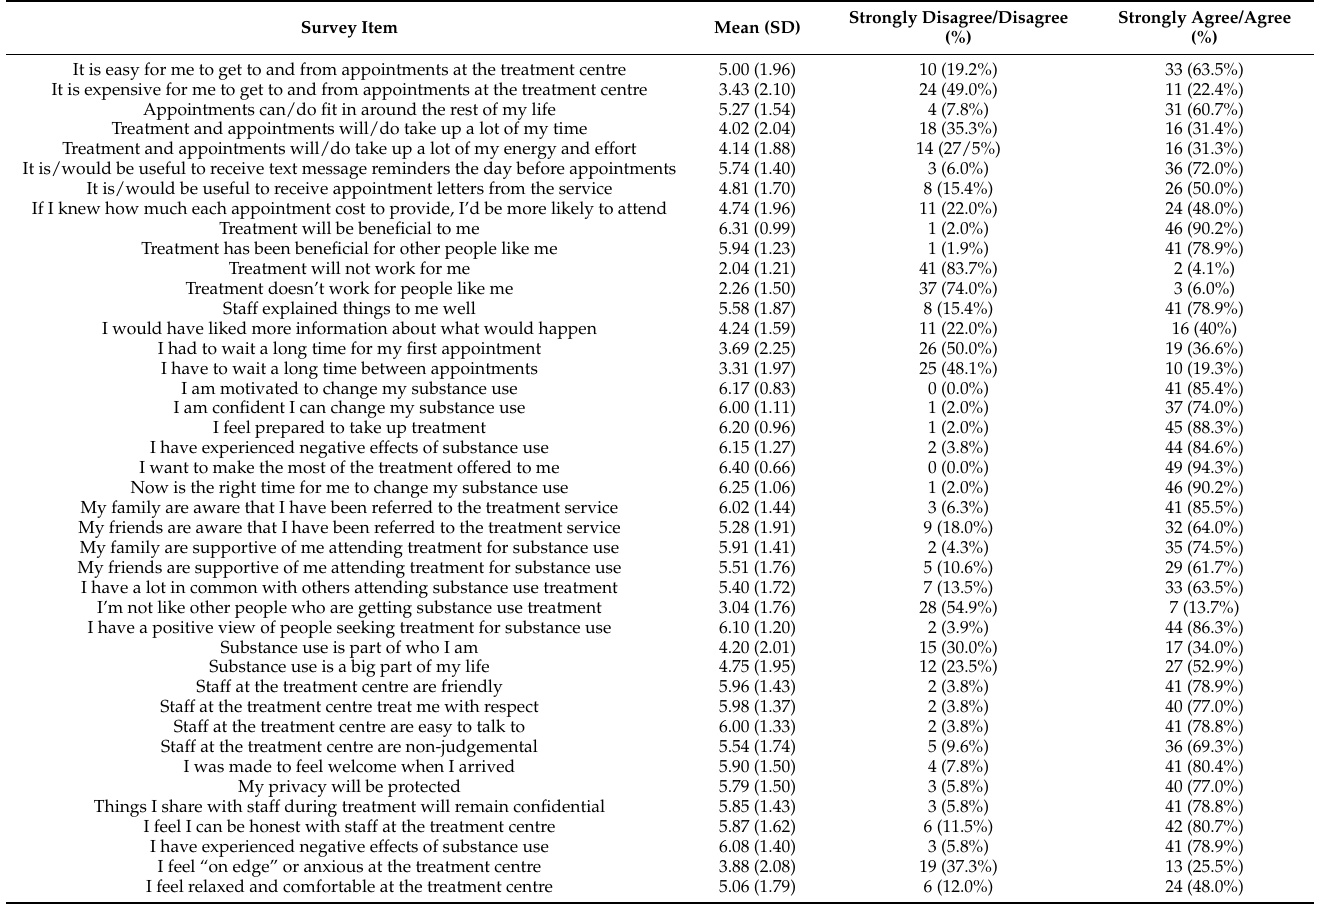
Table 2. Summary of responses to survey